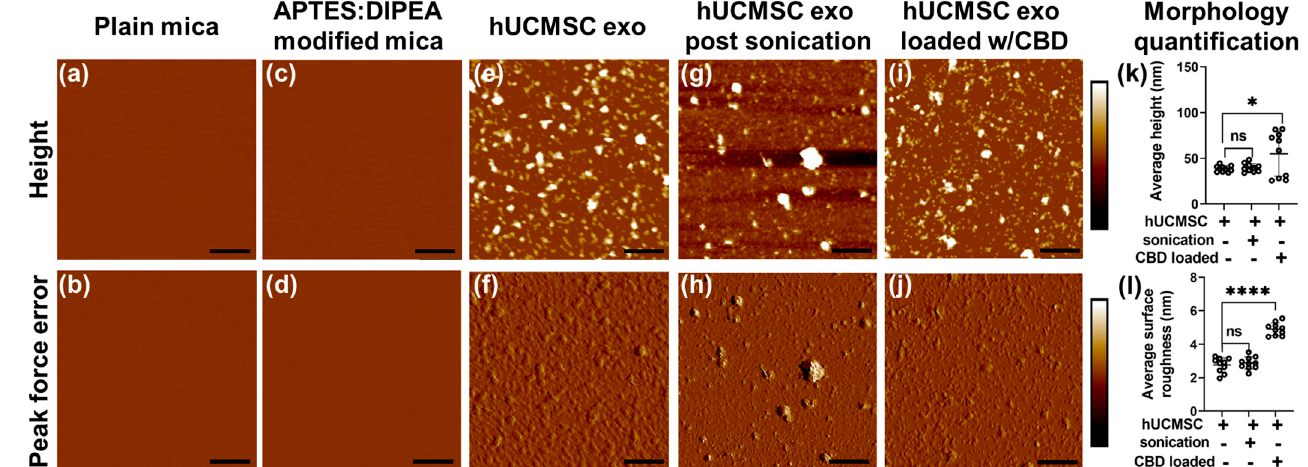
Figure 2. Morphology and corresponding quantification of human mesenchymal stem cell (hUCMSC) EVs under various conditions. Representative images of plain mica ( a ) Height image ( b ) Peak force error image. Representative images of APTES: DIPEA modified mica ( c ) Height image ( d ) Peak force error image. Representative images of hUCMSC-derived EVs ( e ) Height image ( f ) Peak force error image. Representative images of hUCMSC EVs post sonication (control) ( g ) Height image ( h ) Peak force error image. Representative images of hUCMSC EVs loaded with CBD ( i ) Height image ( j ) Peak force error image. (Scale bar: 1 µ m; color bar for height image: − 65 nm to 65 nm; color bar for peak force error image: − 300 pN to 300 pN). Morphology quantification ( k ) Average height ( l ) Average surface roughness. (Statistical significance: ns; not significant. *, p < 0.05 and **** p <